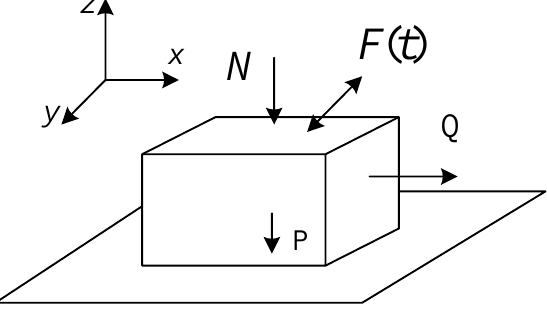
Figure 4. Model of the vibratory material under arbitrary